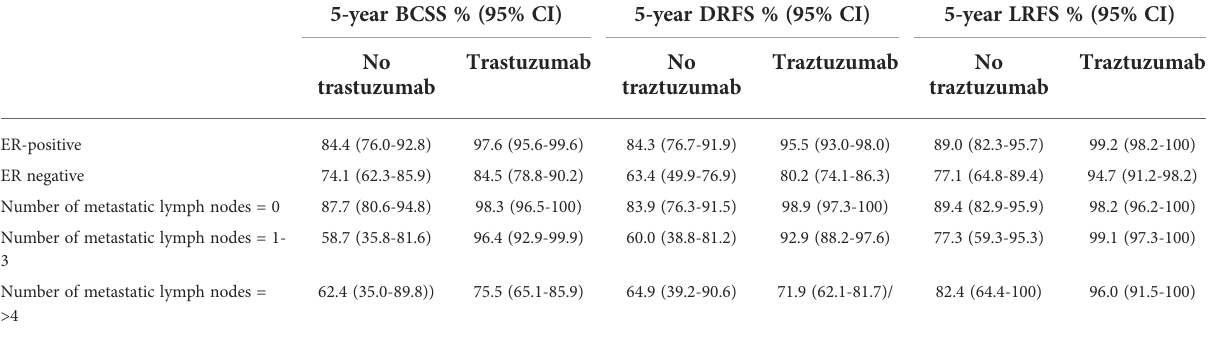
TABLE 2 Subgroup dependent 5-year survival rates.